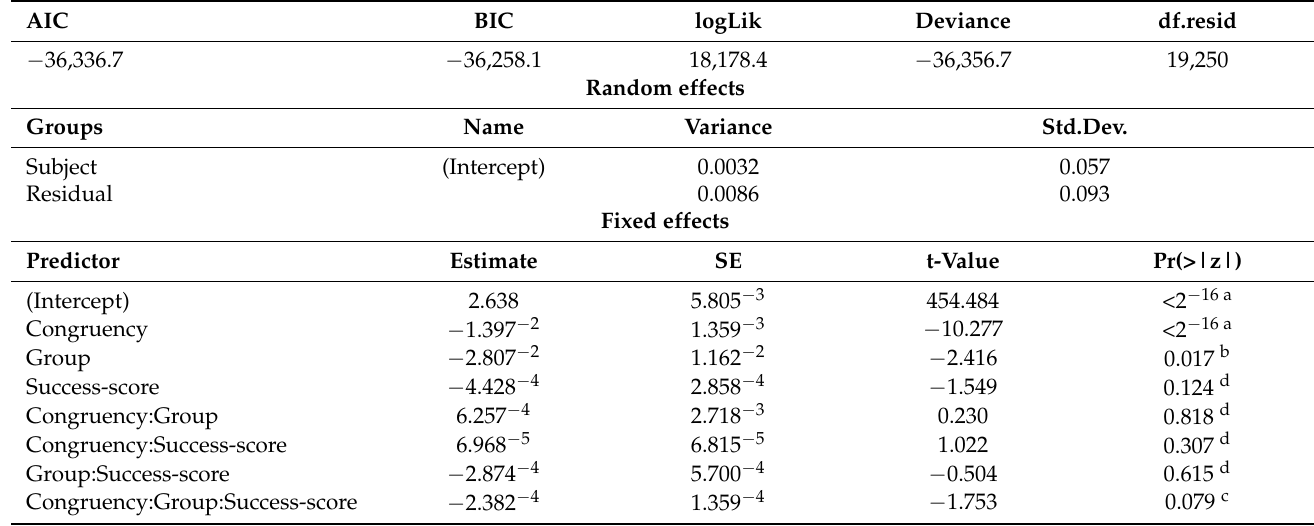
Table 3. Summary of random and fixed effects (RTs) when the subject-specific success scores were included in the statistical model (exploratory